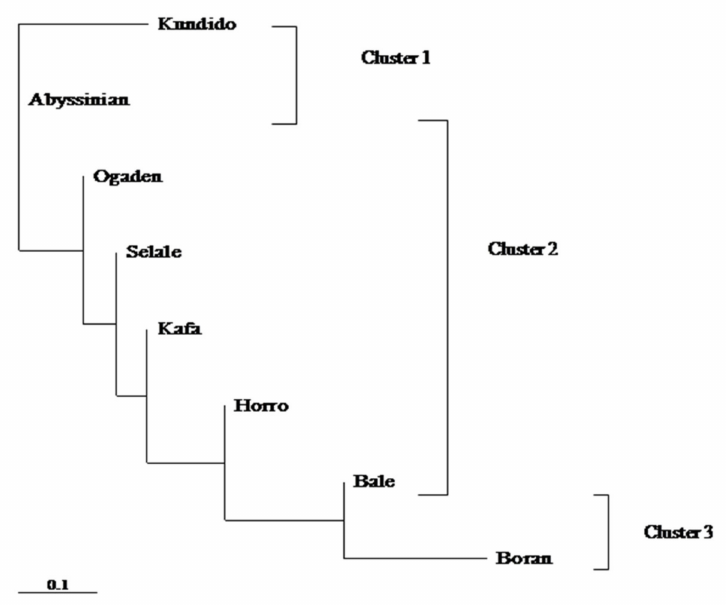
Figure 4. Unrooted neighbor-joining dendrogram constructed from Slatkin’s linearized genetic distances [15]) and Kimura 2-parameter